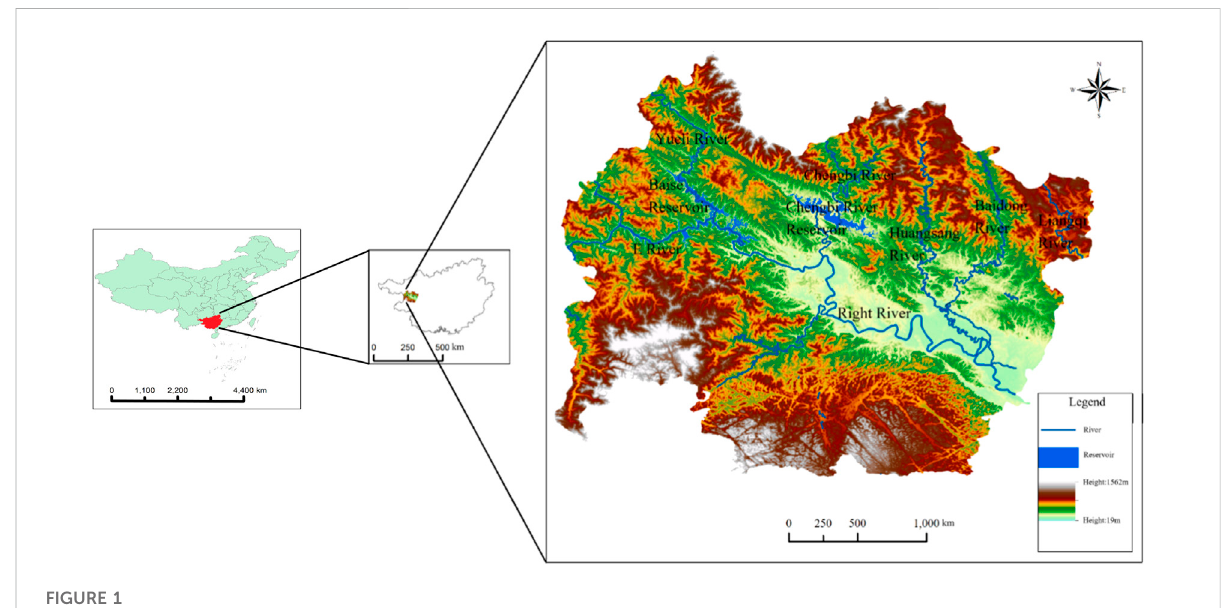
FIGURE 1 Geographical location of the study